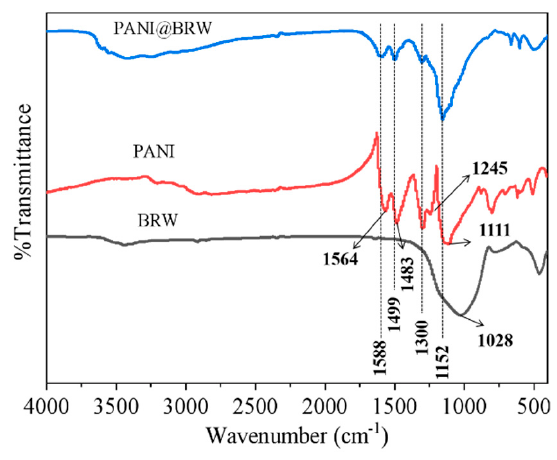
Figure 4. Fourier-transform infrared (FT-IR) spectra of BRW, PANI, and PANI@BRW.